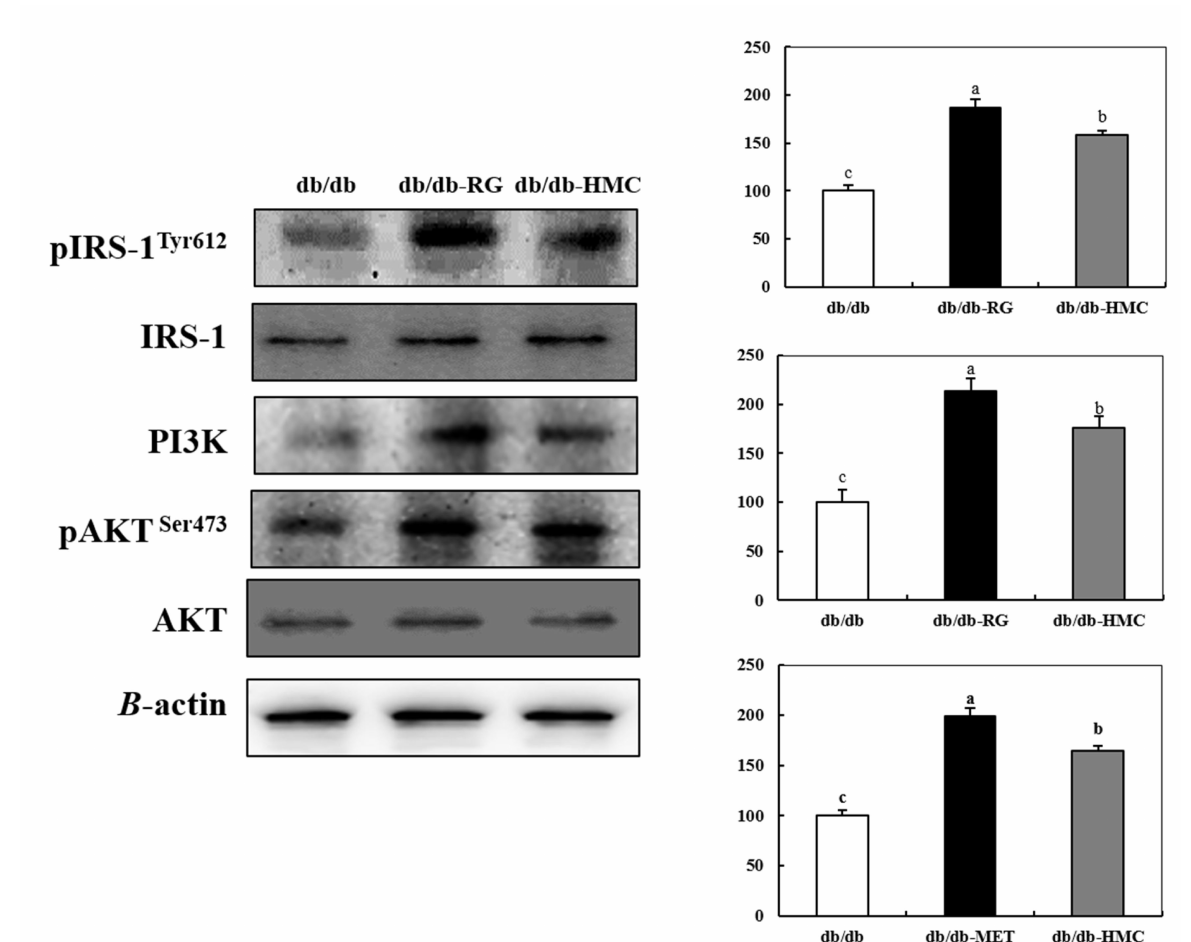
Figure 5. The effects of HMC administration on pIRS-1 Tyr612 , PI3K, and pAKT Ser473 expression in skeletal muscle of C57BL/KsJ db/db mice. Mean ± SD ( n = 8). a–c The mean values that are not indicated by a common letter are significantly different among the groups ( p < 0.05) according to Duncan’s multiple range test. SD, standard deviation. db/db, db/db-RG (5 mg/kg BW per day) and db/db-HMC group (30 mg/kg BW per